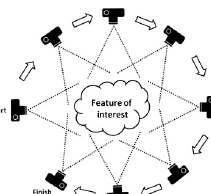
Figure 7. Structure-from-Motion. (Westoby et al.,